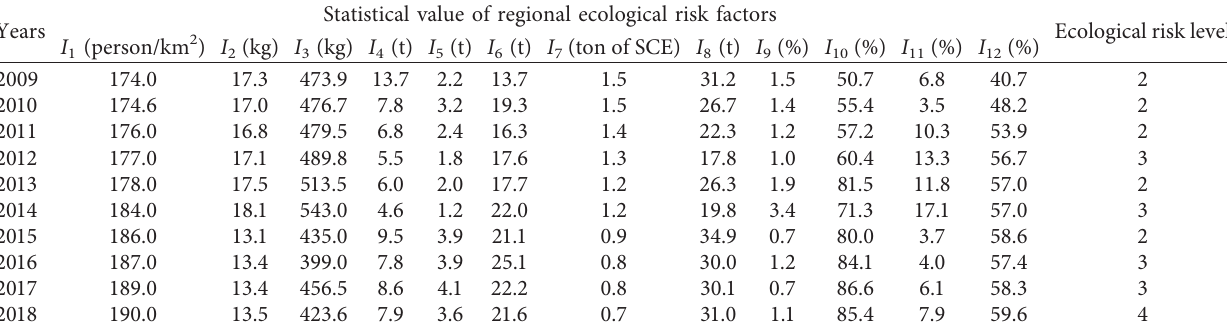
Table 1: Statistical data of regional ecological risk factors and ecological risk level.